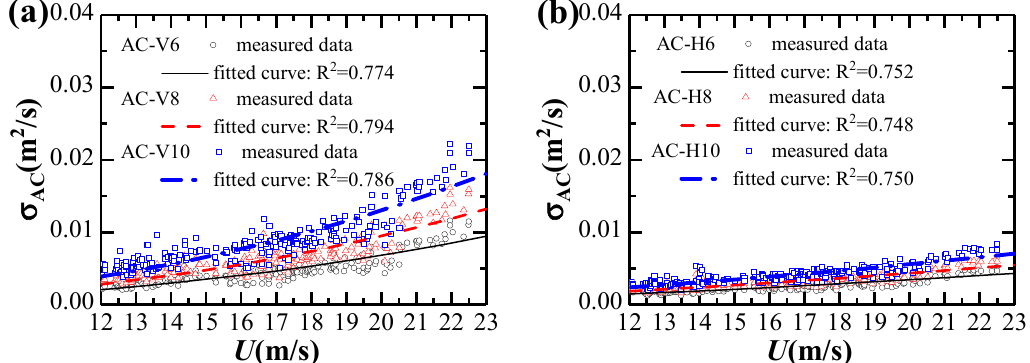
Figure 10. Dependence of acceleration responses on strong winds: ( a ) Vertical; ( b ) Horizontal.